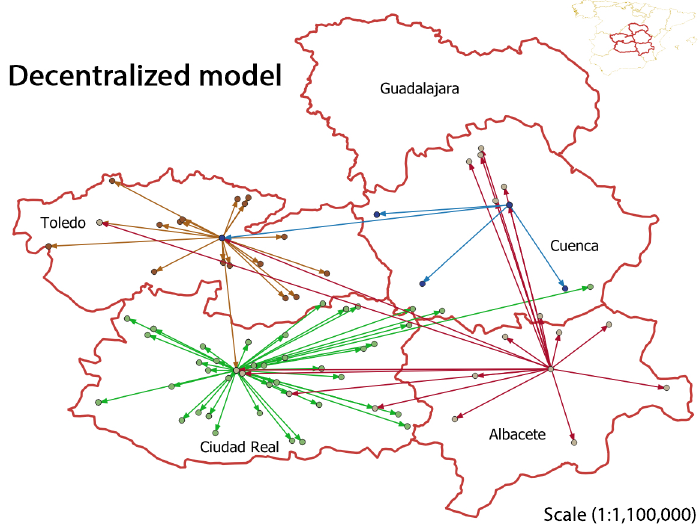
Figure 11. Flux map of the PPE production and delivery in a decentralized organizational model.